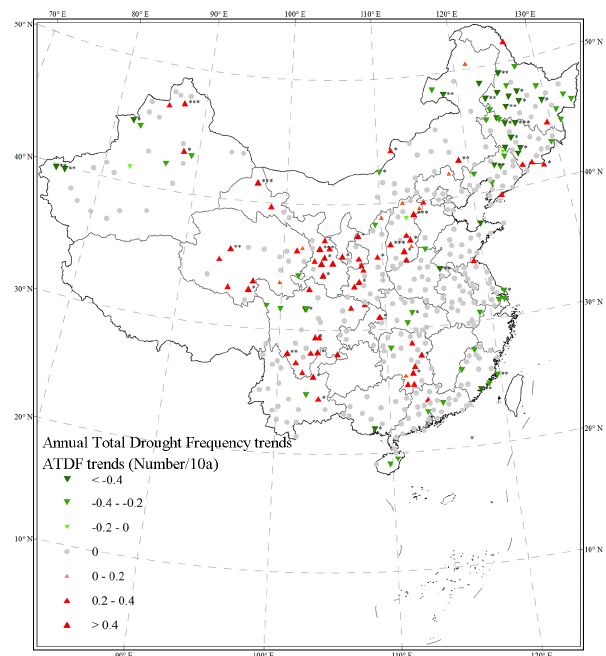
Figure 8. The spatial distribution of the changing trends of ATDF (the red and green triangles indicate increasing and decreasing trends, respectively. “***” denotes P value < 0 . 001, “**” denotes P value < 0 . 01, and “*” denotes P value < 0 .